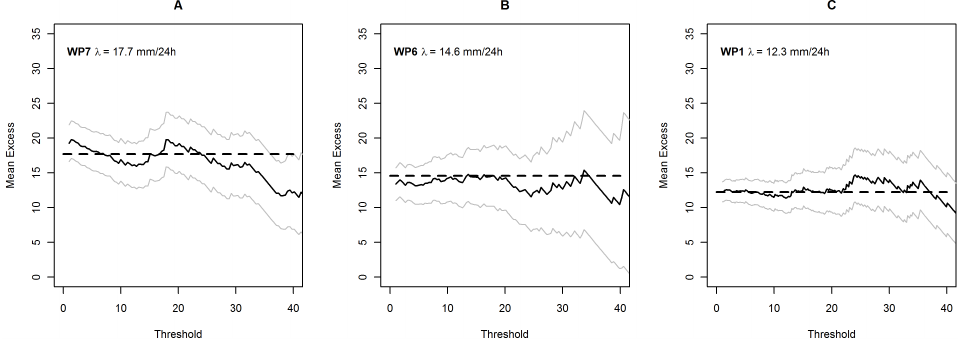
Fig. 7. MRL plot for WP7 (A), WP6 (B) and WP1 (C) days in the season from June to November (“season-at-risk”) at Lyon rain gauge. Gray lines represent the 95% confidence interval. The dashed line highlights the fitted value of the scale parameter according to an exponential